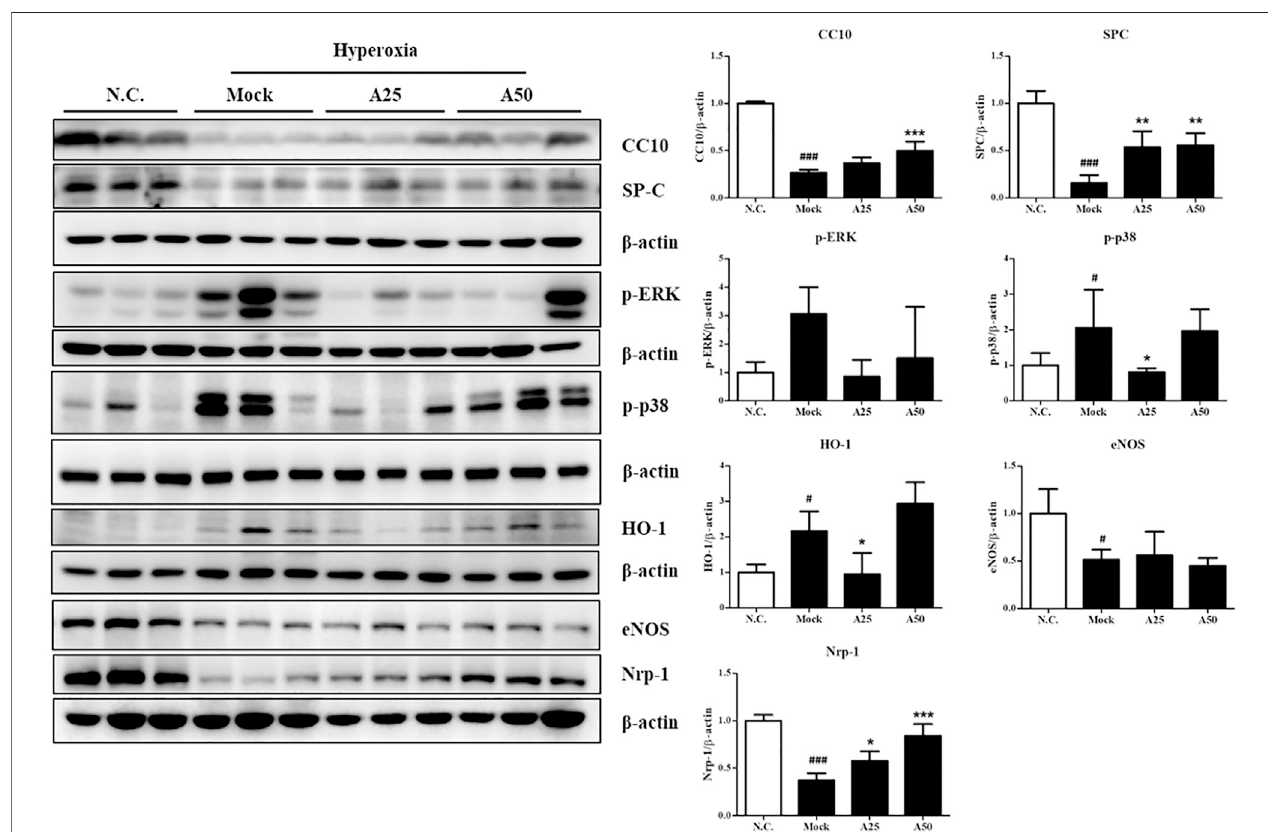
FIGURE 4 | Therapeutic ef fi cacy of aspirin in improving survival and ameliorating the stress response in the lung tissue of NF- κ B-luciferase +/+ transgenic mice exposed to hyperoxia. The bands were quanti fi ed relative to β -actin bands using ImageJ software. The values are reported as the means ± SEM ( n (cid:1) 6 mice per group). # p < 0.05, ## p < 0.01,and ### p < 0.001compared withtheN.C.group;* p < 0.05,** p < 0.01,and*** p < 0.001compared withtheMockgroup.N.C,treatmentwithPBS at0,24,and48 handexposuretonormoxia;Mock,treatmentwithPBSat0,24,and48 handexposuretohyperoxiafor72 h;A25,treatmentwith25 μ g/gaspirin at 0, 24, and 48 h and exposure to hyperoxia for 72 h; A50, treatment with 50 μ g/g aspirin at 0, 24, and 48 h and exposure to hyperoxia for 72